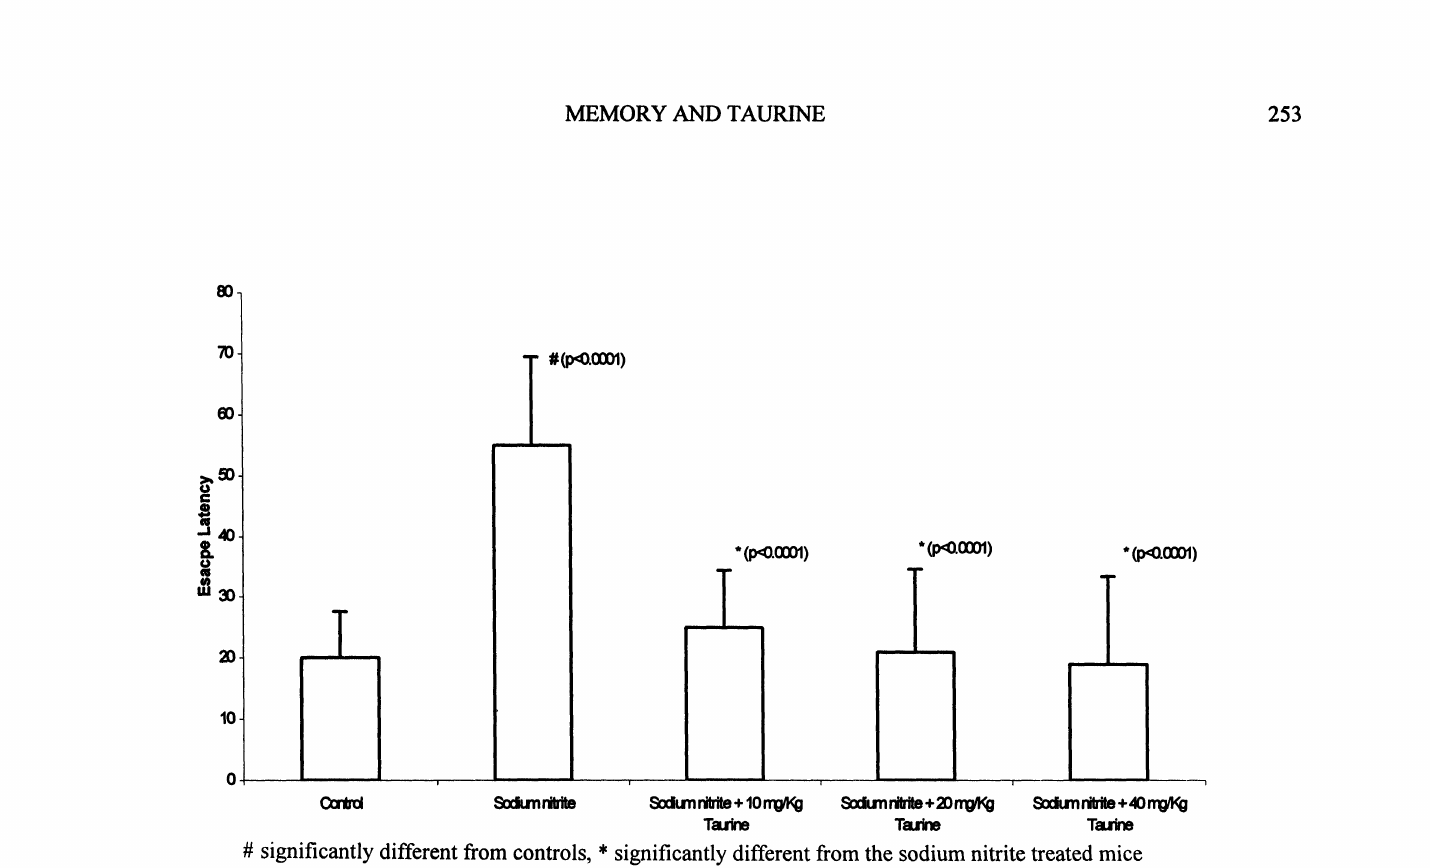
Fig. $" Effect of 30 days of taurine treatment on escape latency in sodium nitrite-treated mice